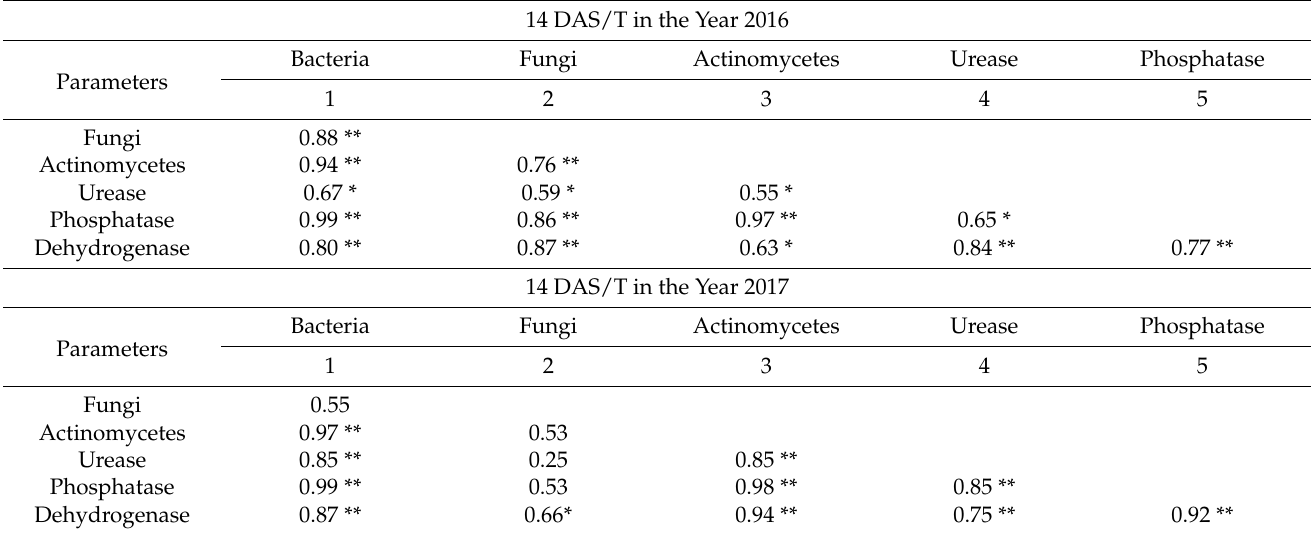
Table 11. Cont. 14 DAS/T in the Year 2016